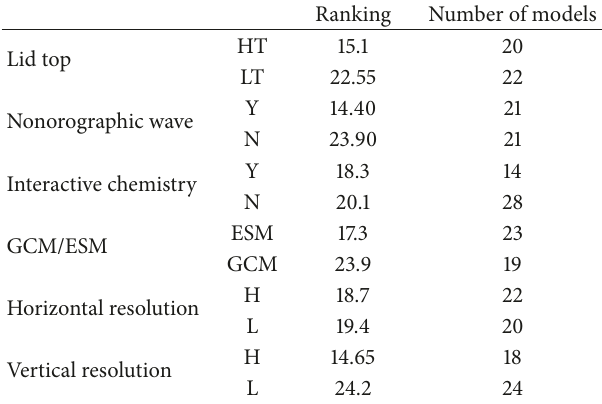
Figure 5: Box plot of the rankings of the models classified into 6 pairs of groups: HT/LTOP models, with/without nonoro- graphic wave drag, high/low vertical resolution in the stratosphere, ESM/GCM, interactive/noninteractive chemistry, and high/low horizontal resolution. In each group, the middle value is the multimodel mean, and the dot is the median value; the upper and lower values are shown for the uncertainty range of the mean, and the uppermost and lowermost bars show the maximum and minimum values. Table 3: The median value of the model rankings of the mean temperatures in the stratospheric polar vortex region, classified into 6 pairs of groups: HT/LTOP models, with/without nonoro- graphic wave drag, high/low vertical resolution in the stratosphere, ESM/GCM, interactive/noninteractive chemistry, and high/low horizontal